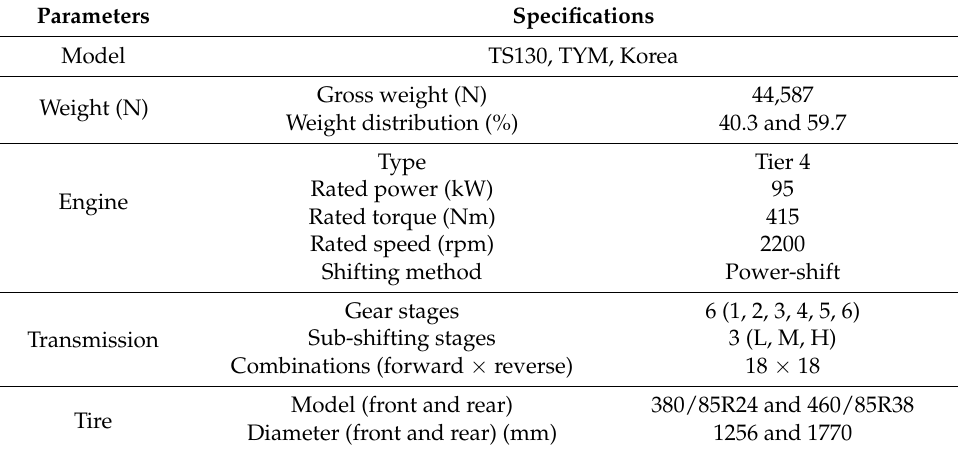
Table 1. The specifications of the power-shift transmission (PST) tractor used in this